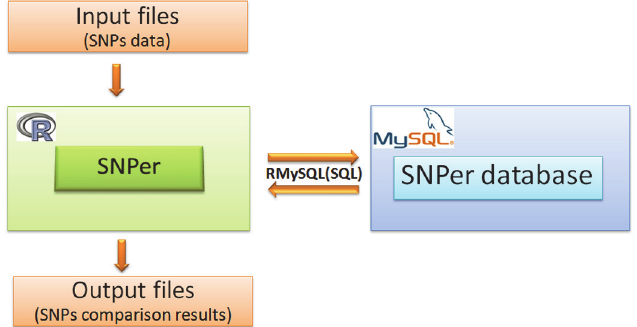
Fig 2. SNPs comparison workflow. SNPer, an R library, analyzes SNPs data using RMySQL and MySQL producing SNPs comparison data as its output.